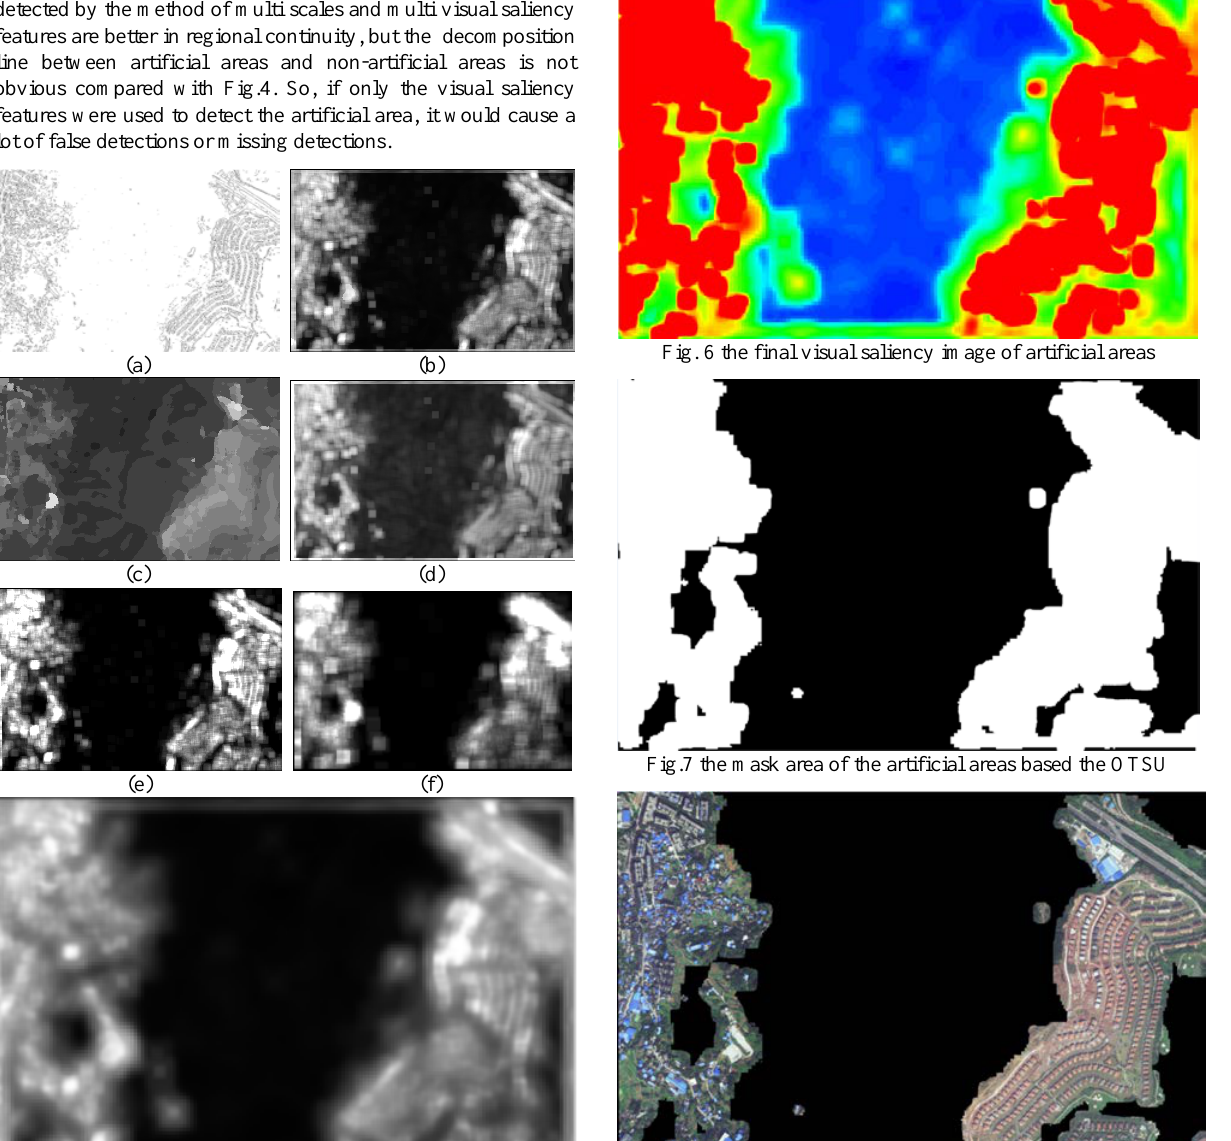
Fig. 8 the artificial areas detected by the method in this paper